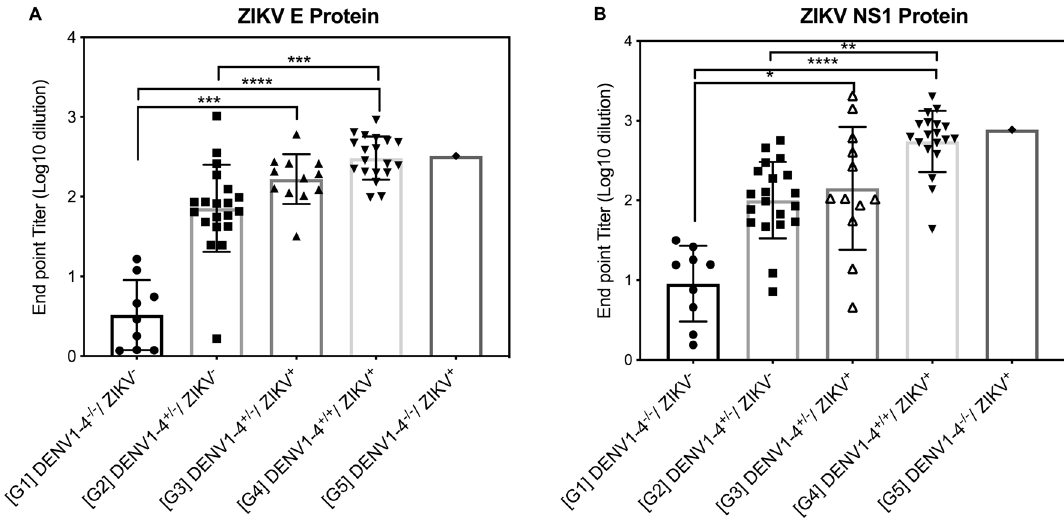
Figure 4. Endpoint titers in anti-ZIKV E and NS1 protein ELISAs for sera grouped by neutralizing activity. IgG against ZIKV E protein (A) and ZIKV NS1 protein (B) were quantified by ELISA for the 61 sera grouped according to the presence or absence of neutralizing antibodies against DENV1–4 and ZIKV as follows. Group 1 (n = 9), negative for all DENV serotypes and ZIKV; G2 (n = 20), positive for between one and three DENV serotypes and negative for ZIKV; G3 (n = 12), positive for between one and three DENV serotypes and positive for ZIKV; G4 (n = 19), positive for all DENV serotypes and positive for ZIKV; G5 (n = 1), negative for all DENV serotypes and positive for ZIKV. Data are presented as the mean ± SD, with each symbol representing an individual sample. *P < 0.05, ** P < 0.01, *** P < 0.001, **** P < 0.0001 by the Kruskal–Wallis test.